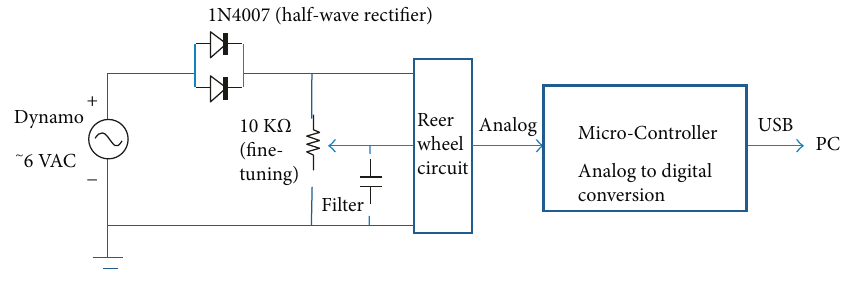
Figure 2: Bicycle wheel rotation measurement